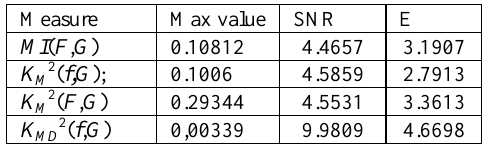
Table 1 Numeric data for TV-IR matching (Example 1).